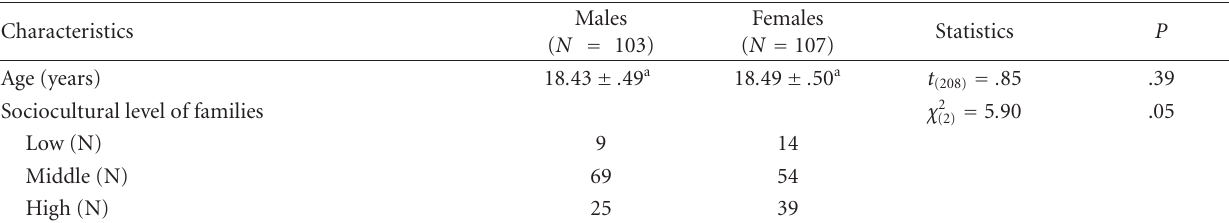
Table 1: Socio-demographic characteristics of